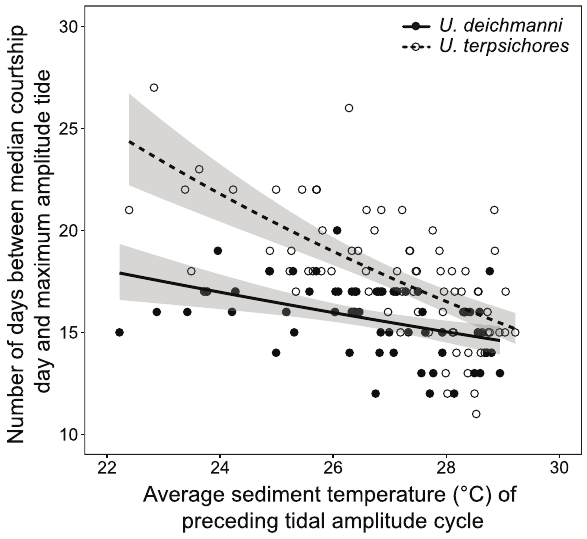
Figure 6. Median courtship timing vs sediment temperature. The number of days between the median courtship day and the night in the following tidal amplitude cycle with the largest amplitude tide (target day for larval release) versus sediment temperature for Uca terpsichores (N=74) and Uca deichmanni (N=59) (Gamma GLM, log link, Temperature: F=53.17, P ,, 0.001, Species: F=44.57, P ,, 0.001, Temperature * Species: F=8.71, P=0.004). Median courtship day was defined as the day when the cumulative proportion of all males observed courting during the courtship cycle surpassed 0.5. Sediment temperature is the average temperature at 20 cm depth during the preceding tidal cycle (minimum amplitude tide to minimum amplitude